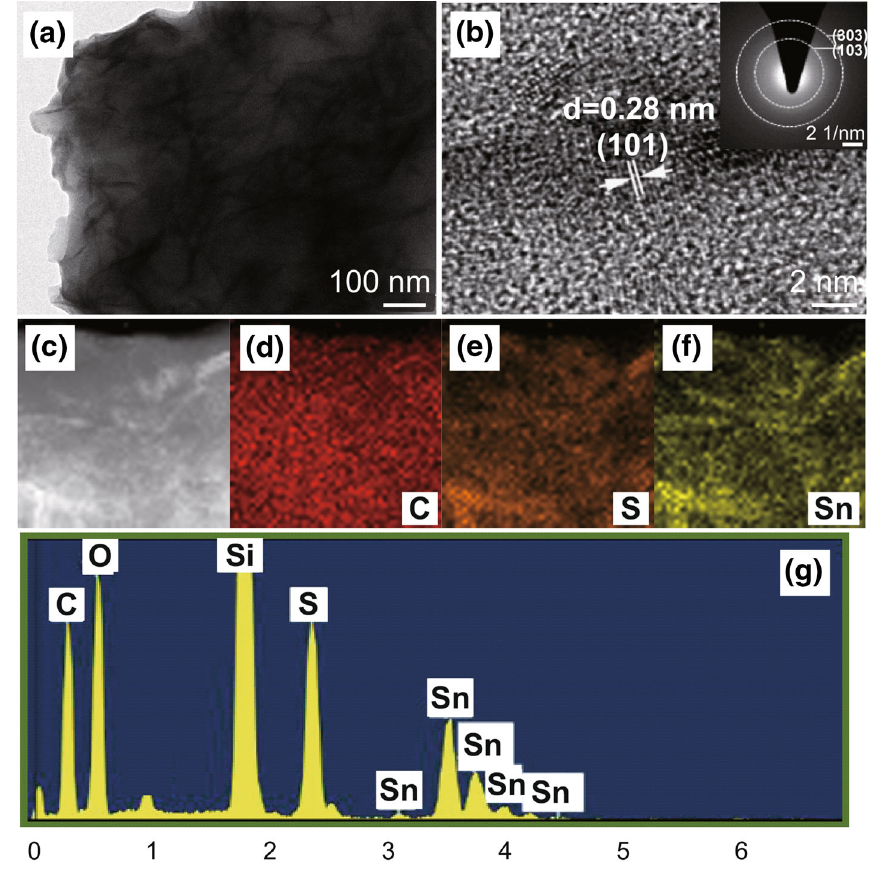
Fig. 4 a TEM image, b HRTEM image (inset is SAED pattern), c – f STEM image and corresponding element mappings of the SnS 2 –rGO composite and g EDS spectrum of